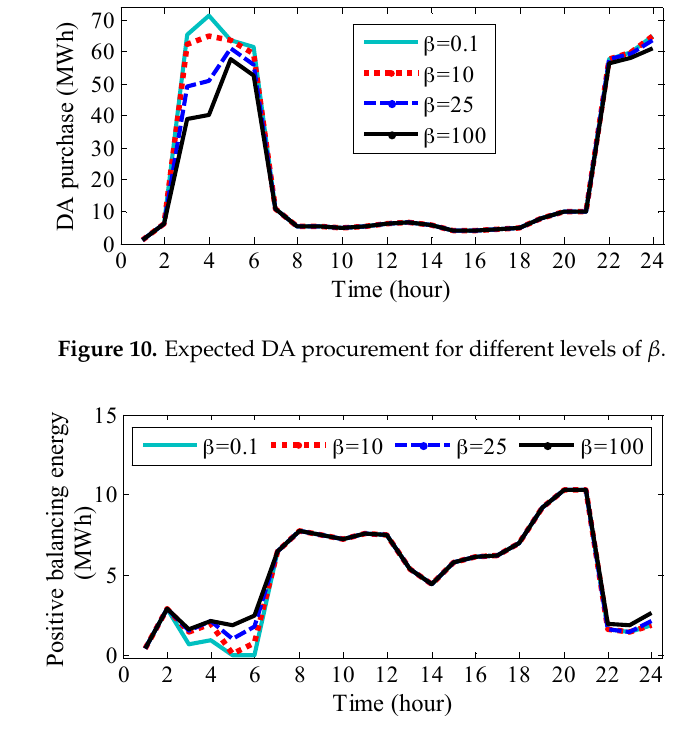
Figure 11. Expected positive balancing procurement for different levels of β .